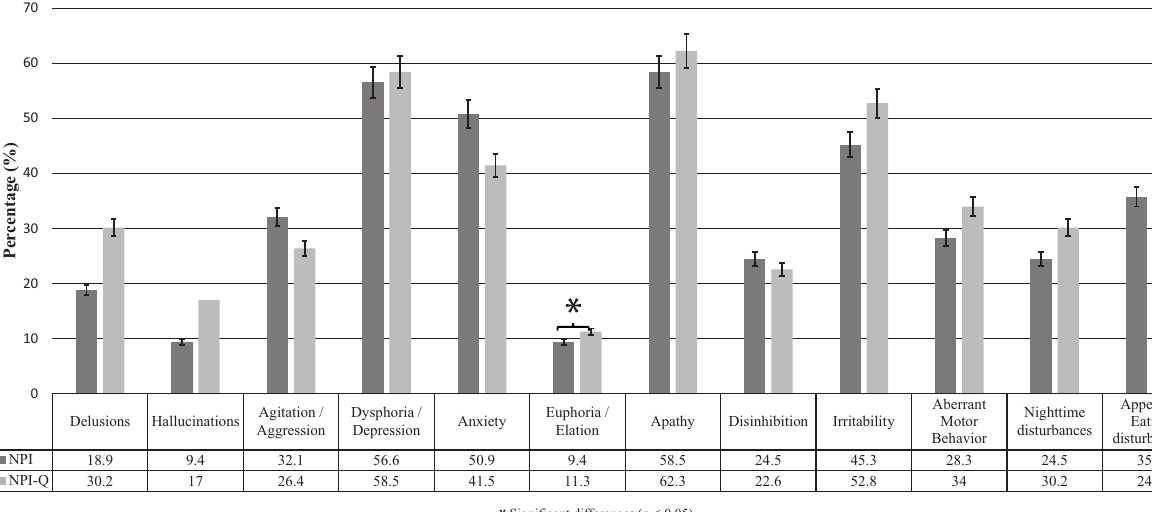
Figure 1. Comparison of the prevalence of neuropsychiatric symptoms in patients with AD using the NPI and the